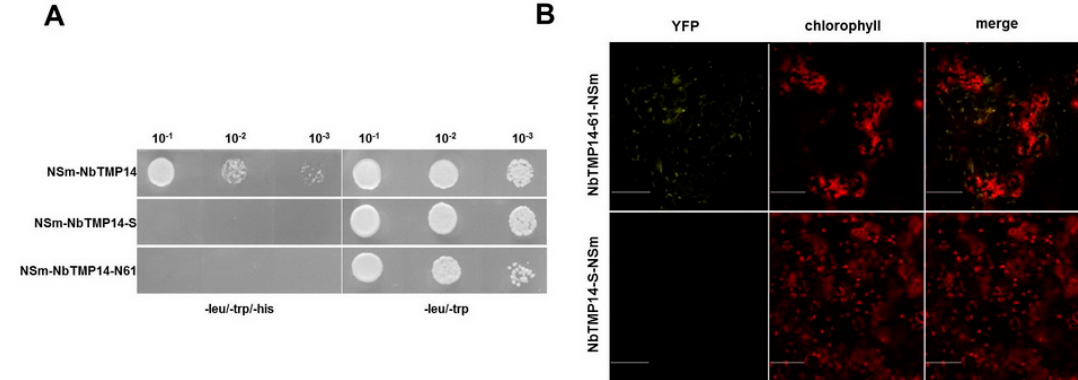
Figure 5. TSWV interacted with the mature form of the NbTMP14 protein. ( A ) Verification of TSWV interacting with the mature form of the NbTMP14 protein by yeast two-hybrid system. ( B ) The interaction between TSWV and the mature form of the NbTMP14 protein was investigated by BiFC in leaves of N. benthamiana . Scale bars represent 100 μ m. These results were further confirmed in plant cells using a BiFC assay. Without the